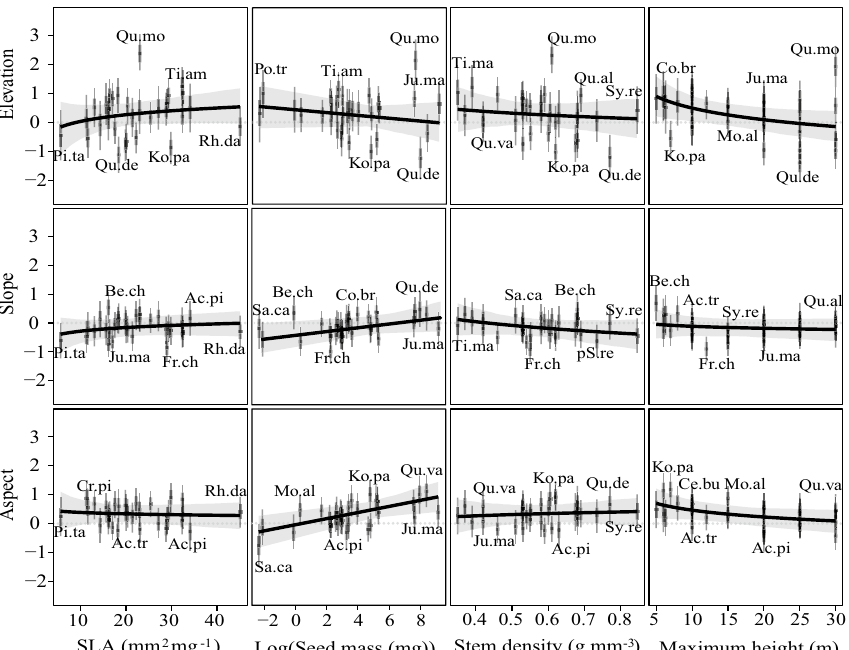
Figure 3. The relationships between environmental responses and species traits given other traits at their medians. The environmental responses were centred, so species with values above zero on the Y-axis had a positive response to the particular environmental variable. Black lines show the coefficient of trait–environment interaction terms in our model. Gray areas refer to the 95% confidence intervals of the estimate. Each boxplot shows the estimated environmental response associated with one particular species trait, given all the other environmental constraints and trait medians. Every boxplot has one square dot with two intervals, representing the mean and 50% and 95% credible intervals. Species names were shortened following Supplementary Table S1 online. For a better illustration, the values of seed mass were log transformed. “*” and “**”indicate that the coefficients of the associations were